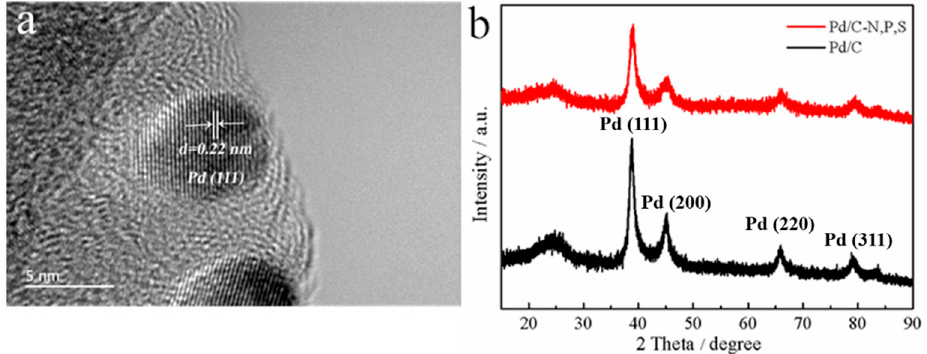
Figure 2. ( a ) The high-resolution TEM (HRTEM) image of the sample Pd/C–N,P,S, ( b ) X-ray diffraction (XRD) patterns of C–N,P,S, Pd/C and Pd/C–N,P,S.